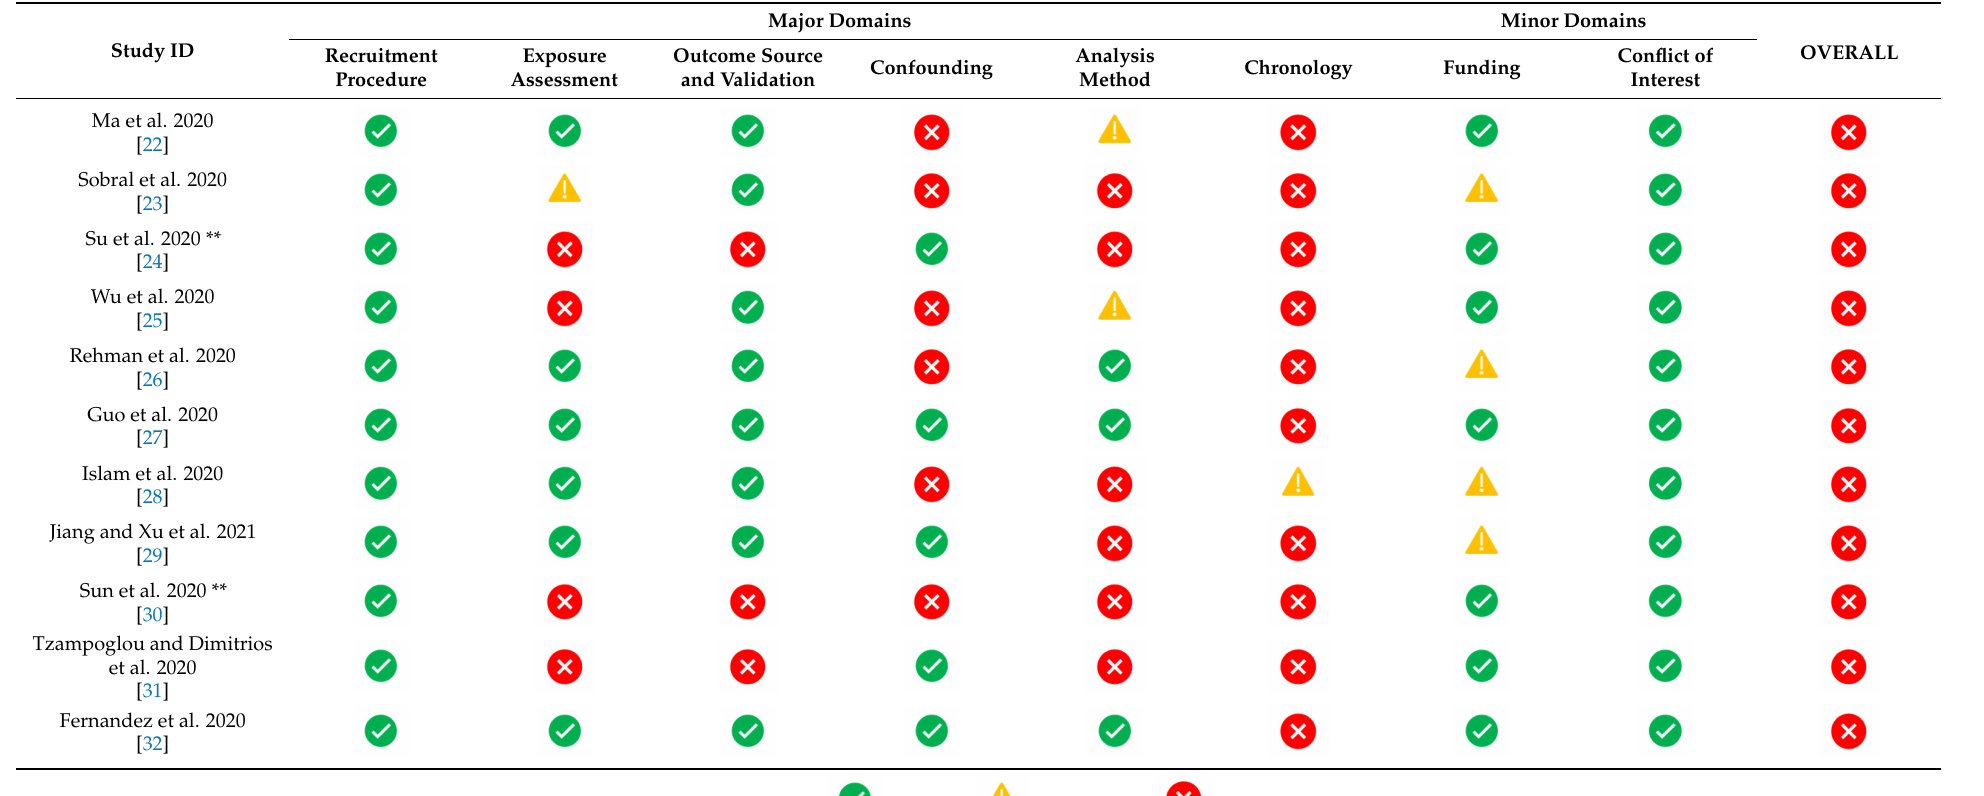
Table 3. Risk of bias in the included